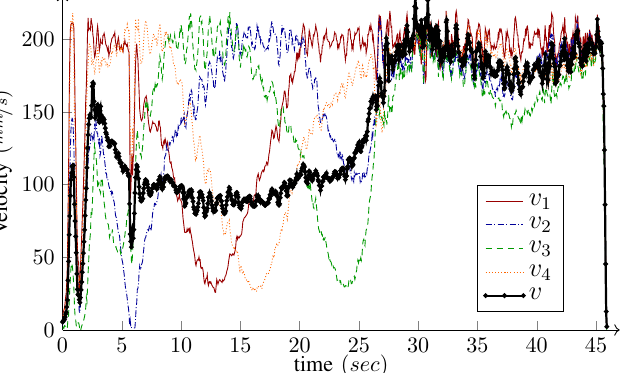
Figure 16. Experiment : Driving velocities v i , and the base speed v , for the bounded-velocity path- following of iMoro depicted in Figure 15. The maximum driving velocity for all the wheels ( v (max) set as 200 mm/s. The base speed is selected to be v = v (max) , given by Equation (26) in Algorithm